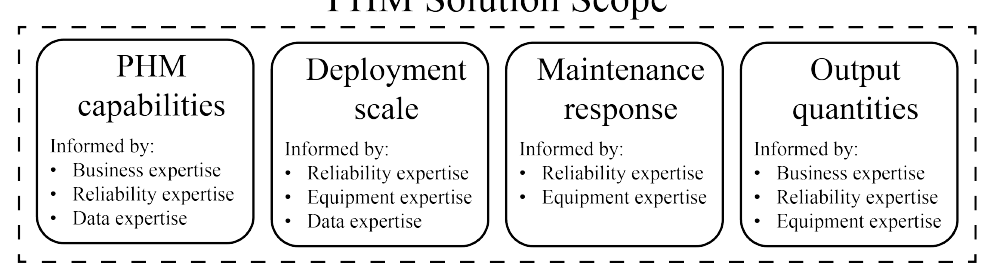
Figure 2. Specifications that constitute the scope of an industrial PHM solution and the subject matter expertise that should inform